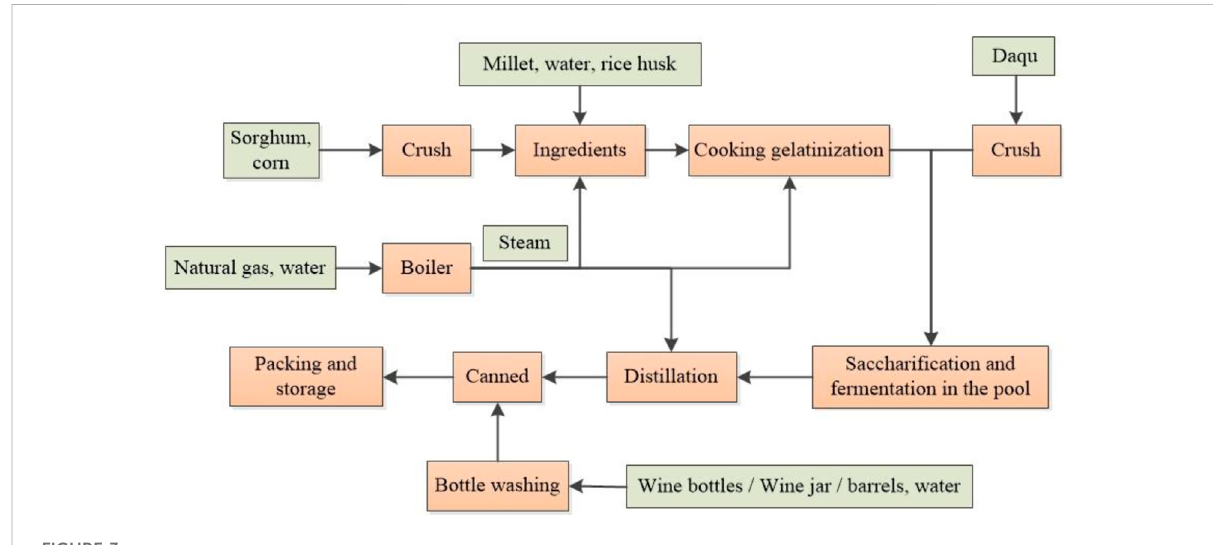
FIGURE 3 Process of liquor